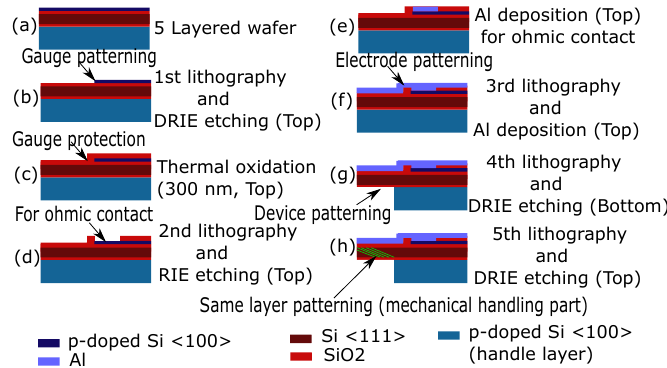
Figure 7. Fabrication process of the cavalier using a 5-layer wafer.